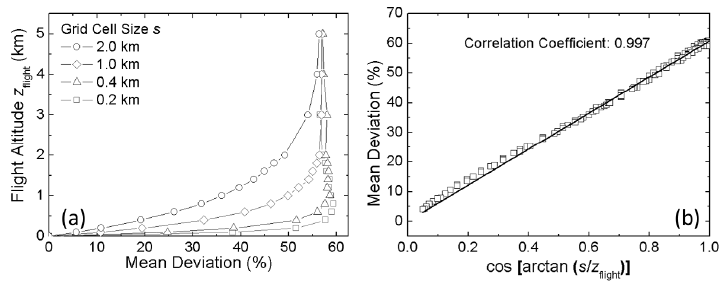
Fig. 7. (a) Vertical profile of the mean albedo deviation 1 for different horizontal resolutions. (b) Correlation of mean albedo deviation and cos θ with θ =arctan (s/z flight ) .